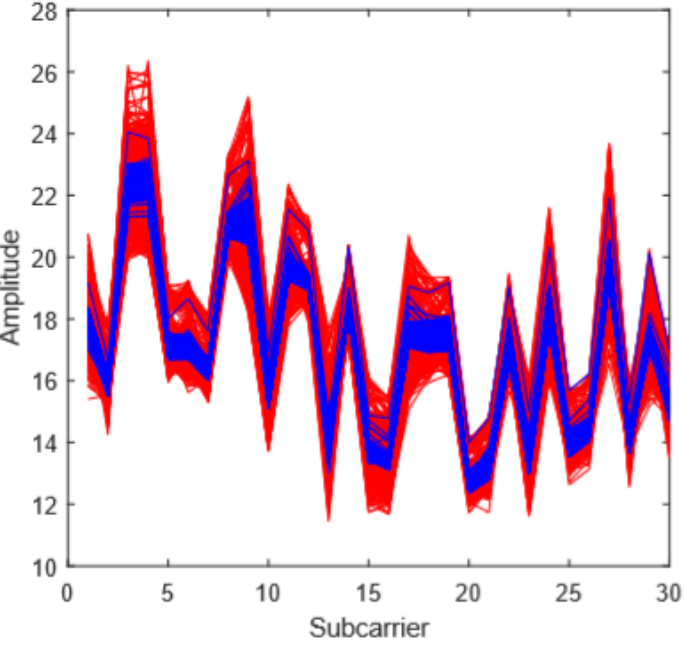
Figure 6. The data smoothing